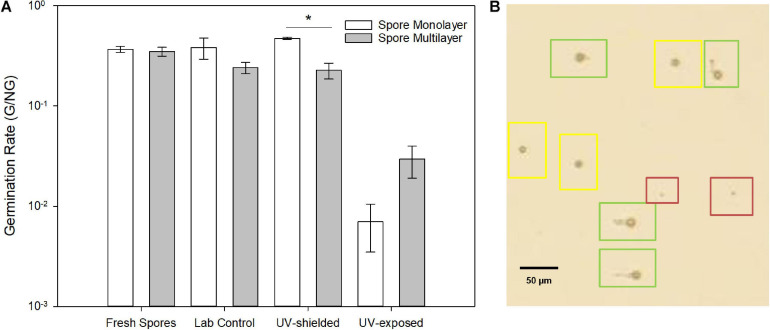
(A) Germination rate (G/NG) of A. niger spores after exposure to simulated Mars conditions. (B) Light microscopy showing resting spores (red), swollen spores (yellow) and germinated spores (green). Both resting and swollen spores were counted as ungerminated.